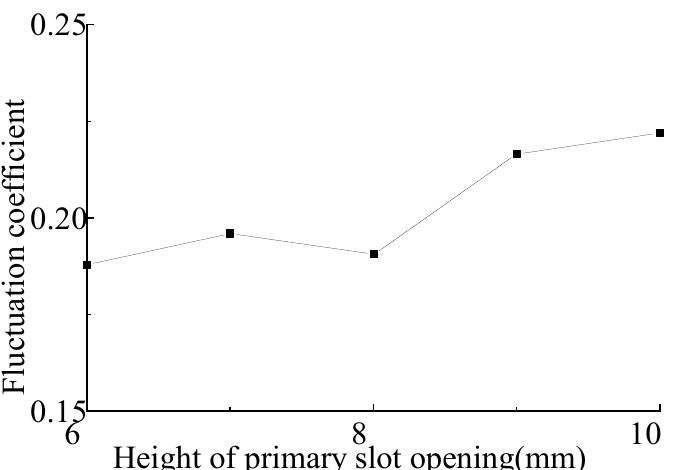
Figure 14. Relationships between output power and efficiency and the height of primary slot open- ing.